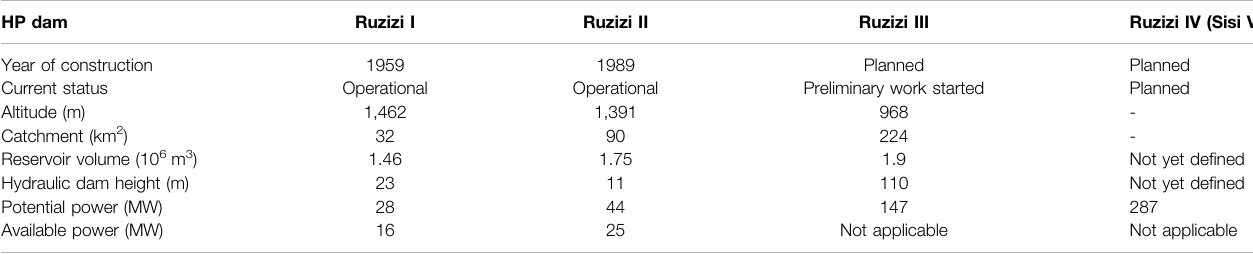
TABLE 1 | Characteristics of the Ruzizi hydropower dams (*)